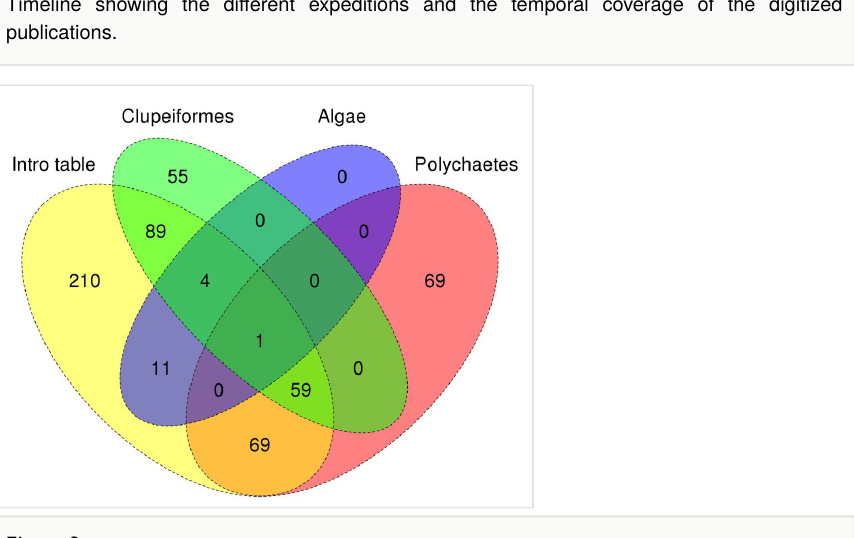
Venn diagram showing the overlap of sampling stations across the four digitized